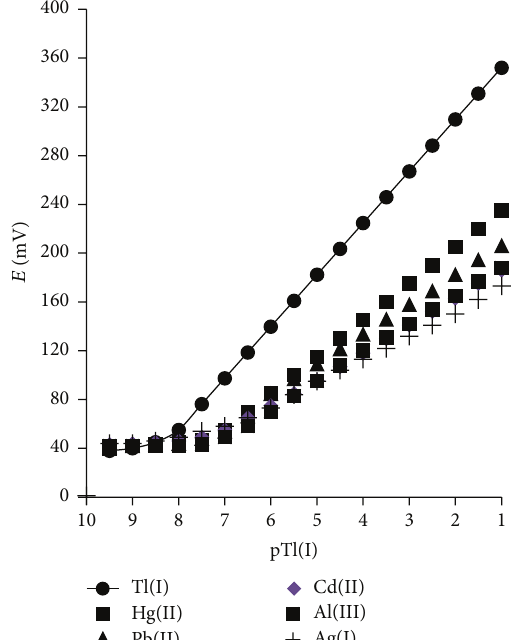
Figure 1: Potential response of CPE8 for different cations.